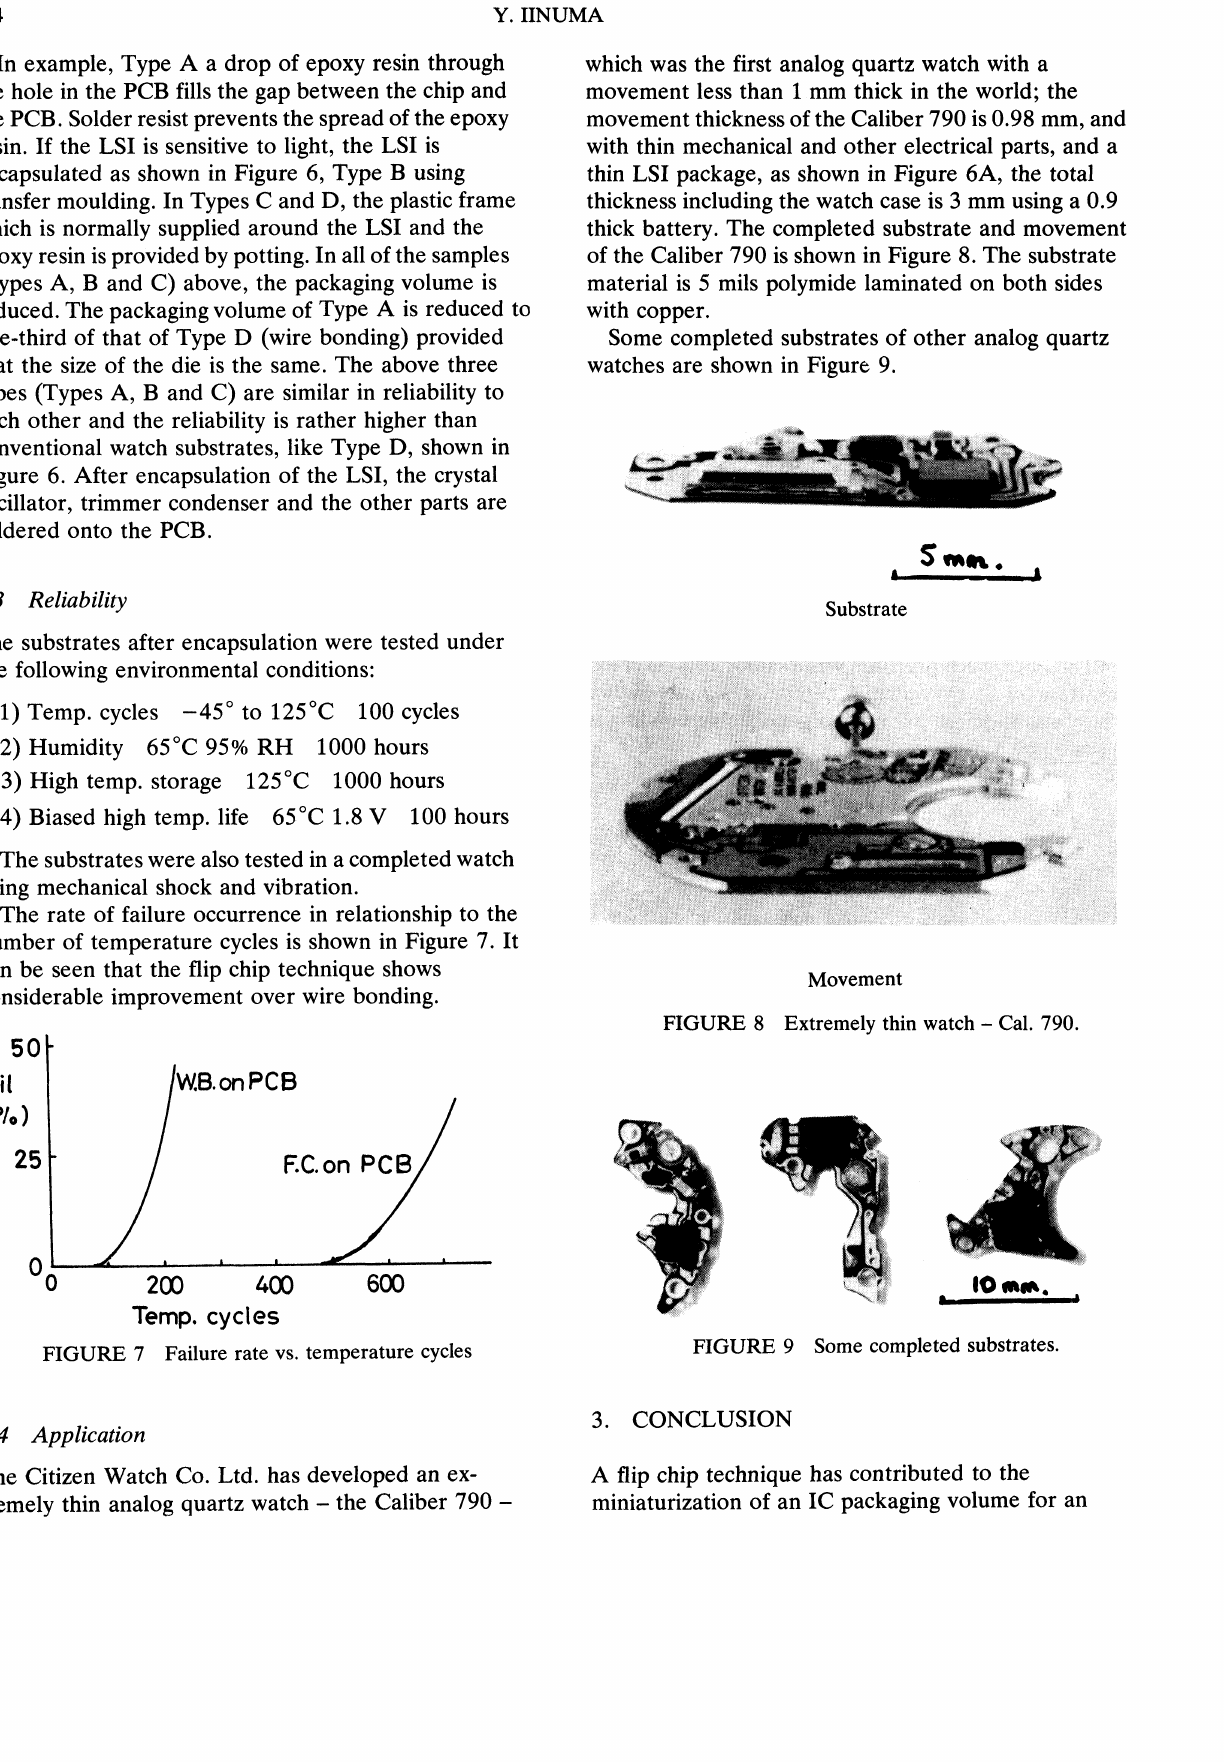
FIGURE 7 Failure rate vs. temperature cycles